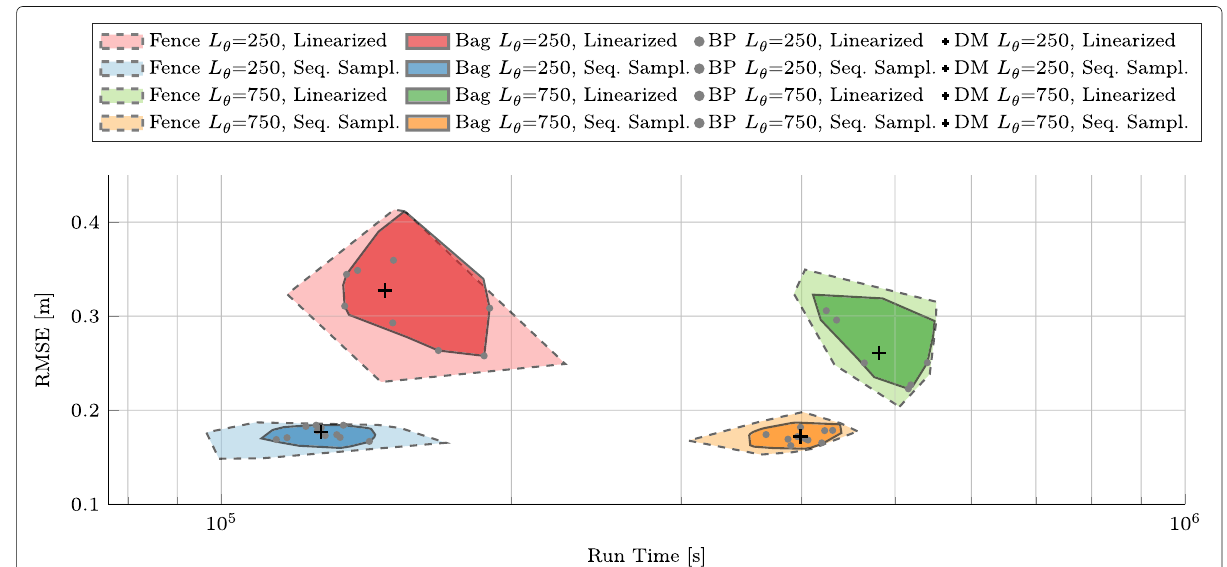
Fig. 9 Run-time and performance comparison between sequential sampling (cf. Section 6.2) and linearization (cf. Section 6.1) for L = 316 and MNS 1 as bagplots. Bagplots, as proposed in [33], are a generalization of boxplots for two objectives and consist of the following parts. The bag that contains at most 50% of the points in the dataset. The fence that is an inflated bag by a factor of three. All points outside the fence are considered outliers. The depth median (DM), which is a generalization of median, is the point with the largest Tukey depth. Here, only those data points (DPs) within the bag are visualized for